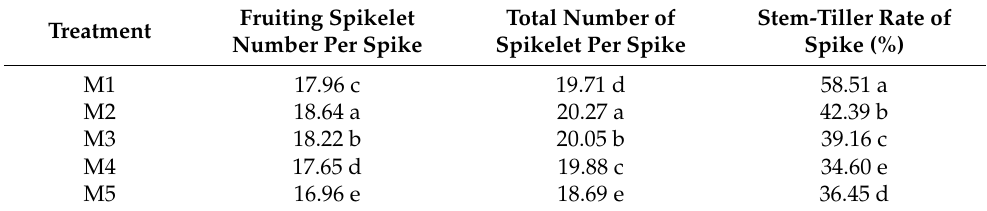
Table 4. Effects of plant density on the number of fruiting spike, total spikelet, and stem-tiller rate of spike.